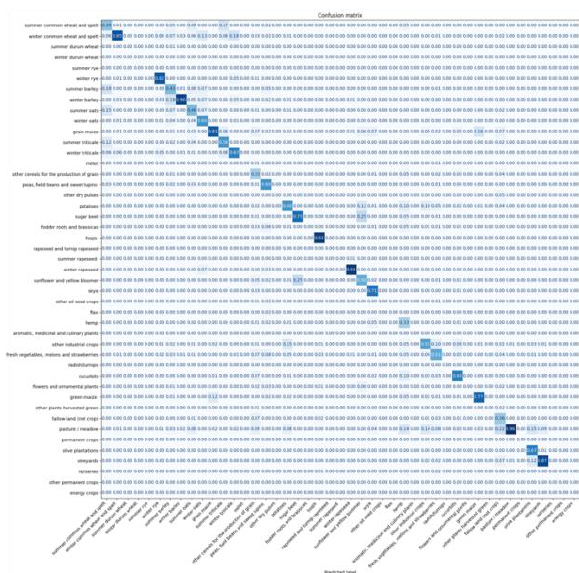
Figure 9. Confusion matrix normalized by predicted